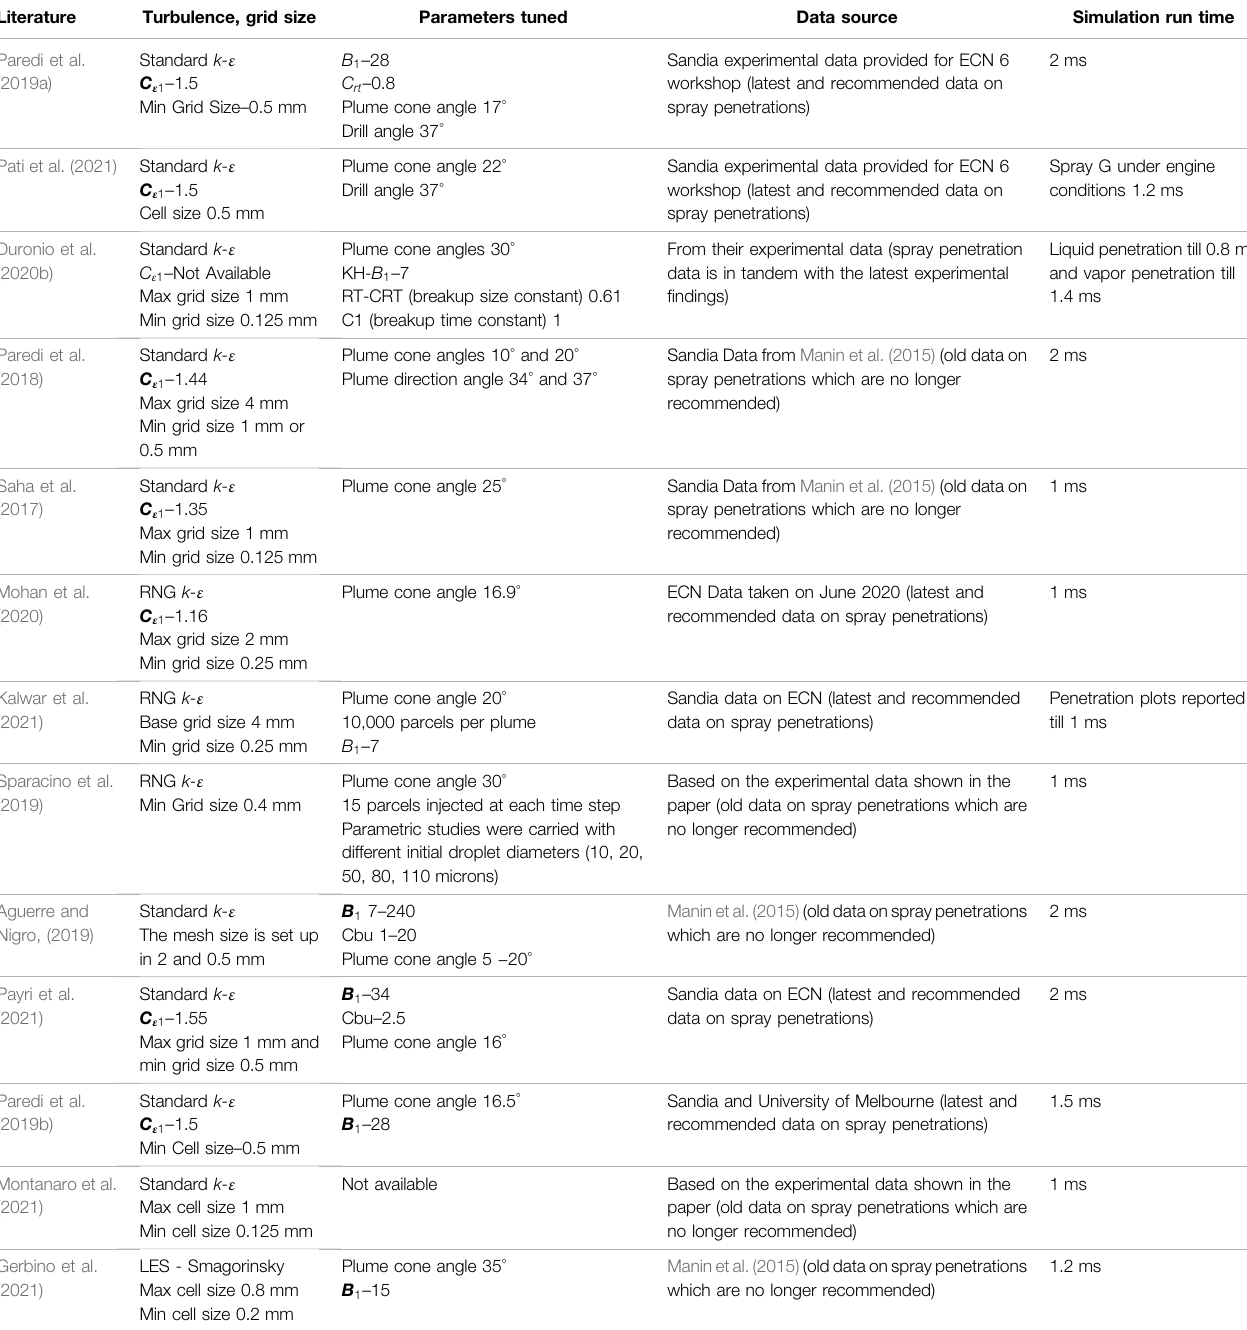
TABLE 1 | Comparison of modeling approach and tuning parameters used on Spray G simulation from the published literature.